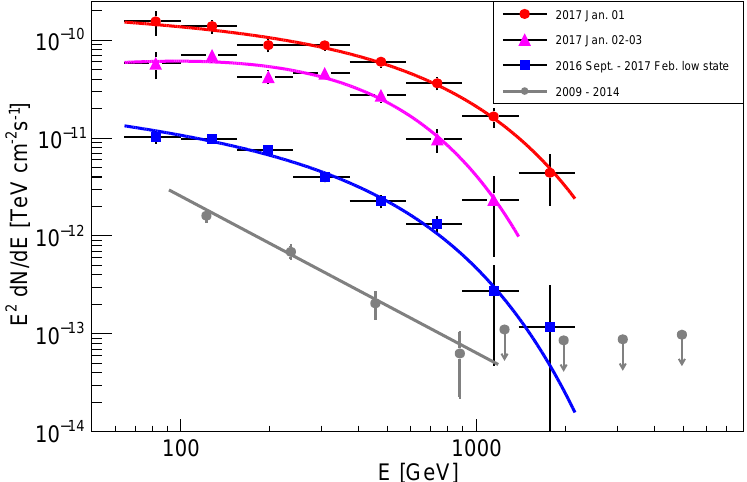
Figure 2. The VHE spectral energy distributions (SEDs) of NGC 1275 as measured by MAGIC during different periods. Significant curvature is evident, suggestive of an exponential cut-off around a few hundred GeV. For comparison the averaged spectrum based on observations in 2009 to 2014 is shown in grey. From Ref.